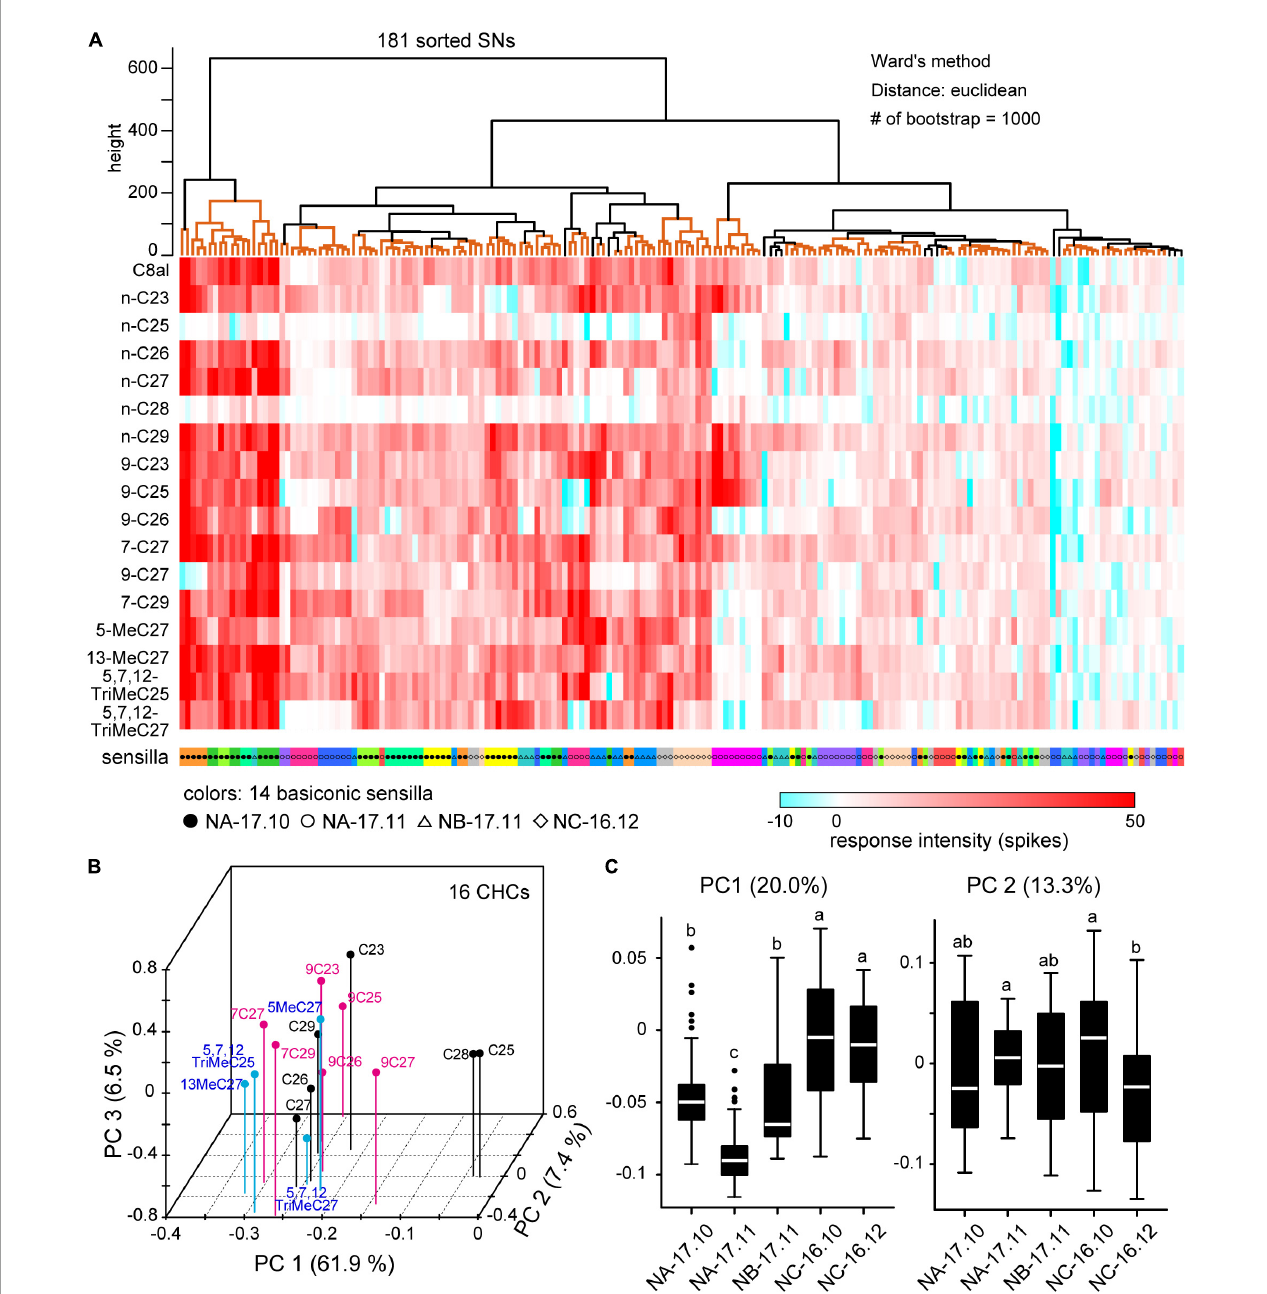
FIGURE6 Cuticular hydrocarbon (CHC) coding of SNs in basiconic sensilla. (A) Response spectra of 181 SNs from 14 basiconic sensilla to 16 CHCs. CHC response spectra of 181 sorted SNs are shown in the heat map. Using cluster analysis and bootstrap P -values ( > 0.90), we grouped SNs based on the similarities of response spectra (clades denoted by orange lines in the upper dendrogram). SNs co-localized in the same sensillum are coded by the same color under the heat map. Black and white circles, triangles and diamonds denoted under the heat map show the colony identities. (B) The receptive space of CHCs. Based on the spatial activity patterns of SNs elicited by each CHC, we performed principal component analysis (PCA). The first three principal components (PCs) are mapped into a 3D receptive space. CHCs that elicited similar spatial activity patterns in SNs mapped closer together. CHCs of alkanes, alkenes and methyl-branched alkanes are differentially color-coded. (C) CHC response spectra for nestmate recognition. Using CHC response spectra of SNs, we performed PCA. The distributions of the first two PCs are summarized based on the colony information, and are displayed as box plots. The line in the box and the box represents the median and the quartiles, respectively. Outliers are shown as dots. The results of multiple comparisons are denoted as different letters on the box plots (one-way ANOVA; P < 0.05).